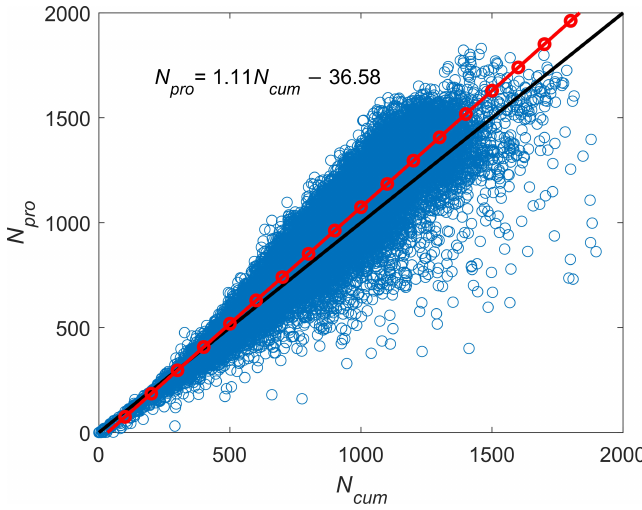
Figure 4. Scatter plot of the number of the first-order Doppler bins determined by the SeaSonde method ( N cum ) versus the number of the first-order Doppler bins determined by the second-order spectra-based method ( N pro ) for each range-Doppler spectrum. The red line marked with circle is the fitted line, and the black line is a